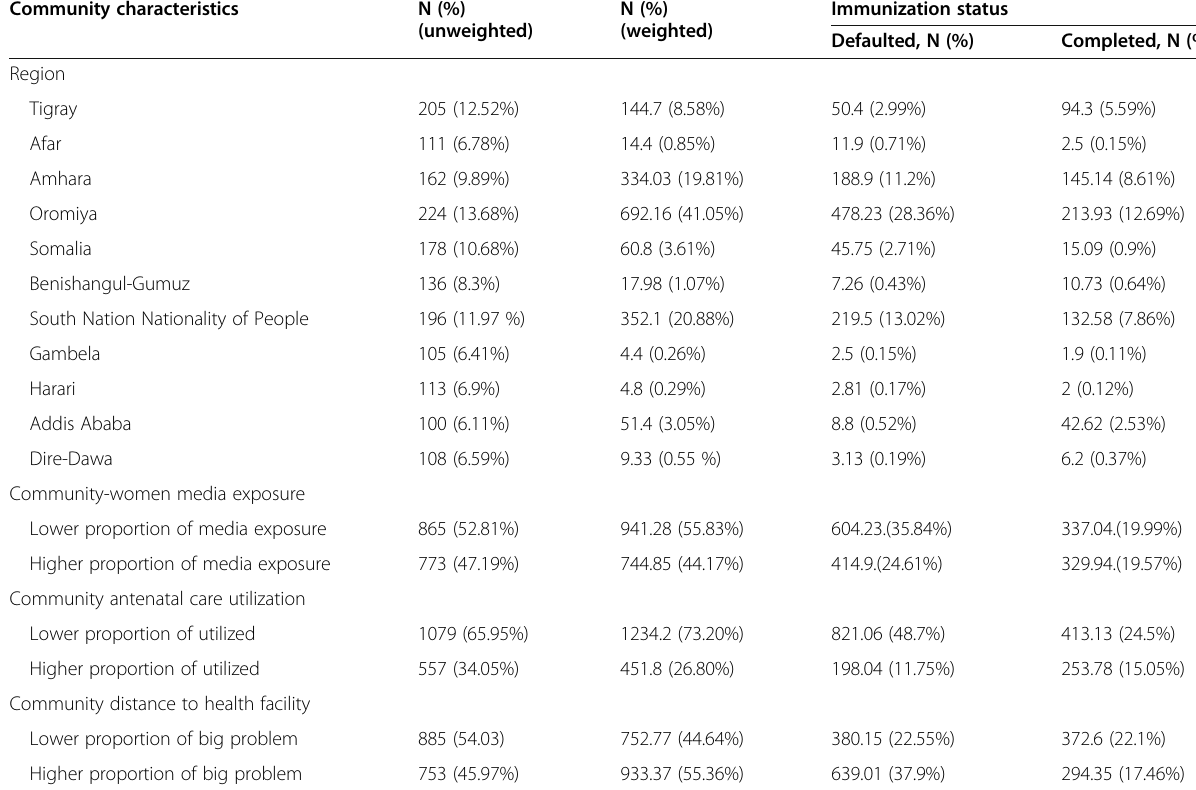
Table 2 Background characteristics of communities among children aged from 12 to 23 months in EDHS 2016 (unweighted n = 1638 and weighted n = 1686) Community